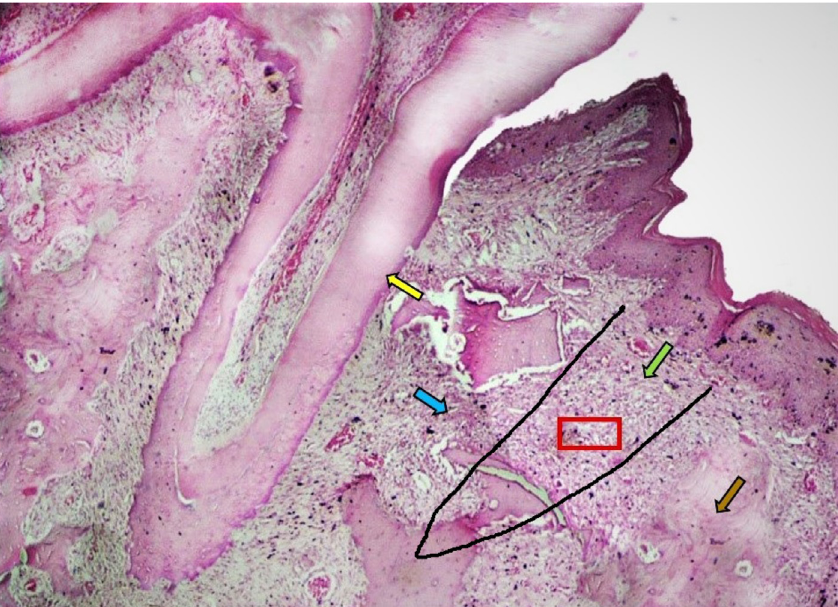
Fig. 2. Photomicrograph of extracted tooth socket of Group A (control), 7 days after extraction, H and E stain, 4X. The image depicts the mesial root of 2nd mandibular molar (yellow arrow). Adjacent to it is the distal root area of extraction socket of 1st mandibular molar (blue arrow). Black line shows the distal root morphology of 1st mandibular molar. Alveolar socket is also evident (green arrow) with adjacent interradicular bone (brown arrow). Red rectangular area highlights part of the area of extraction socket.